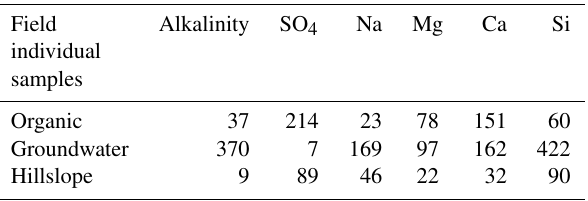
Table 2. The median concentration of individual field-measured end-members from Hooper and Christophersen (1992). All units are in micromoles per liter.